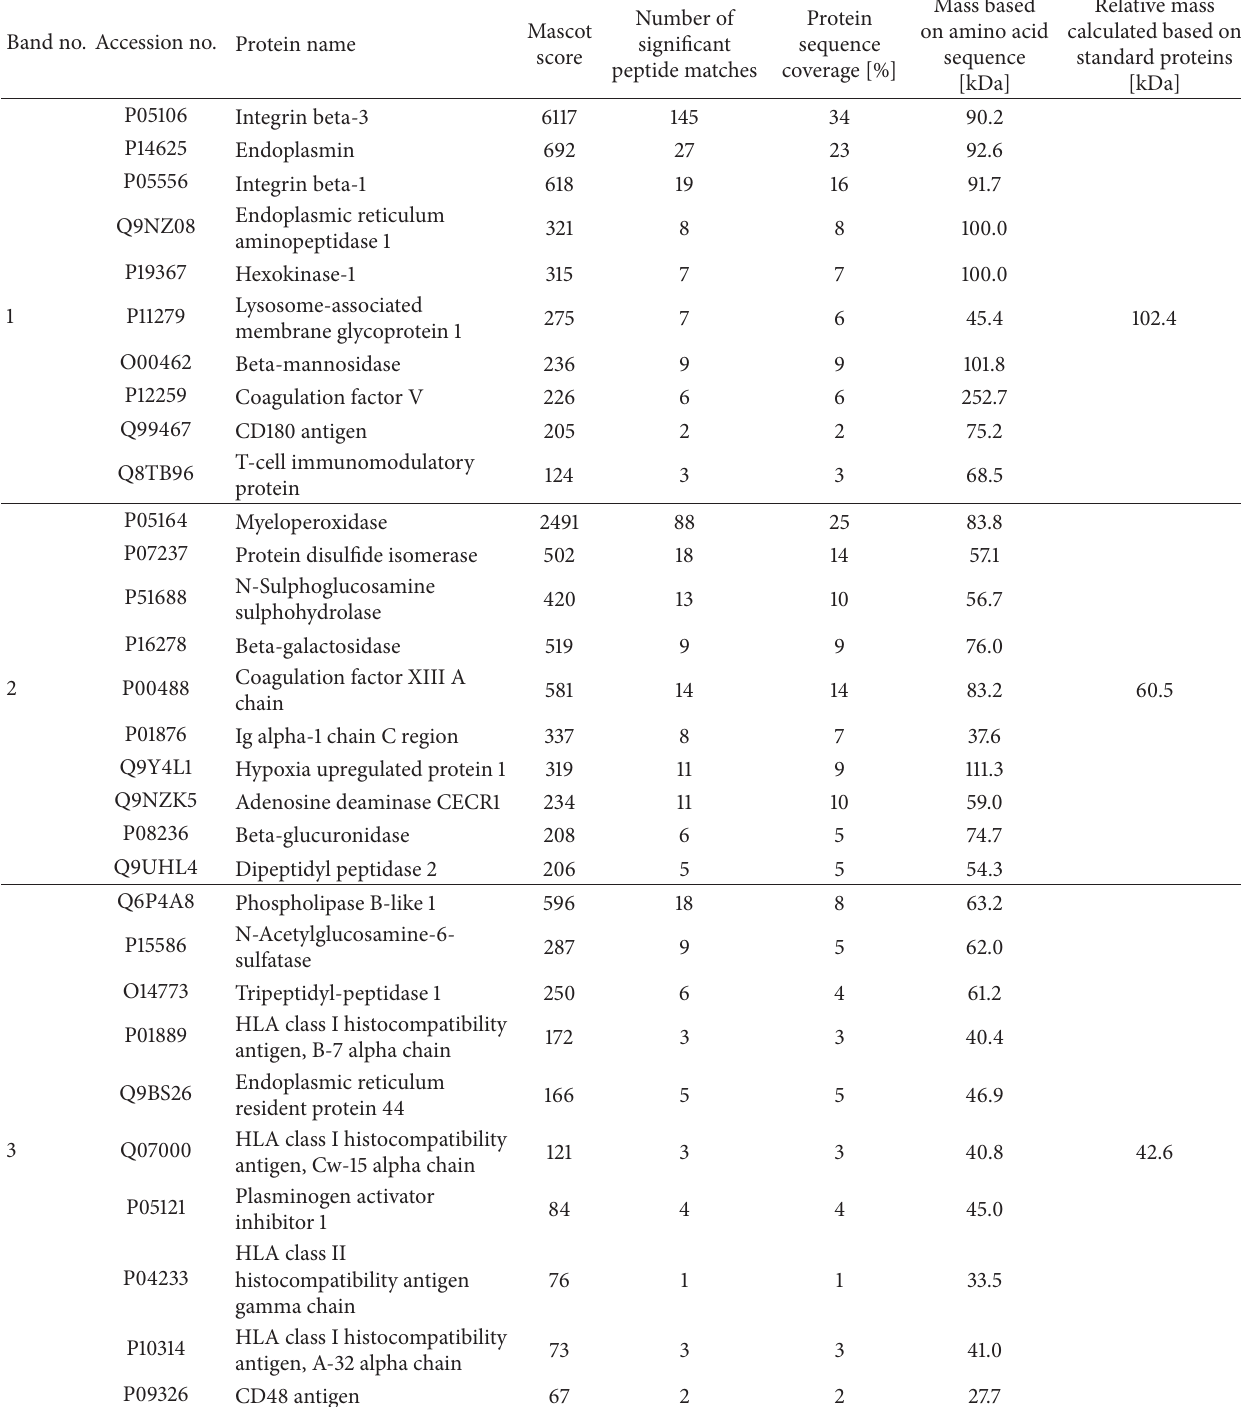
Table 1: Cyclosporin A (CsA) and rapamycin- (Rapa-) affected GNA-positive glycoproteins identified by MS/MS. Proteins bearing high mannose/hybrid-type oligosaccharides expressed on MLR-activated leukocytes treated with a combination of CsA (150 ng per 1mL medium) and Rapa (12ng per 1mL medium) were identified in MS/MS analysis by comparison of the results with the Sprot database. Ten glycoproteins with the highest protein score for each band are